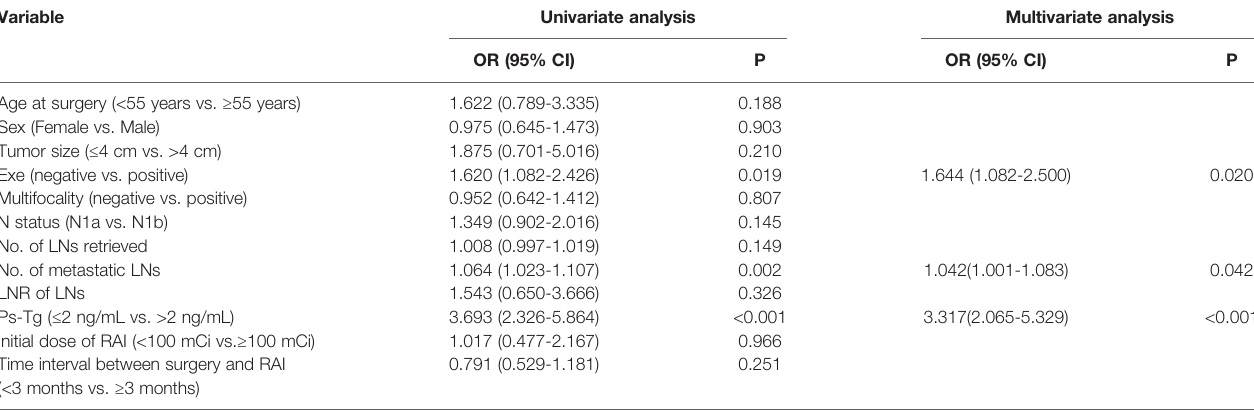
TABLE 2 | Univariate and multivariable analyses of prognostic factors for excellent response for the entire population.